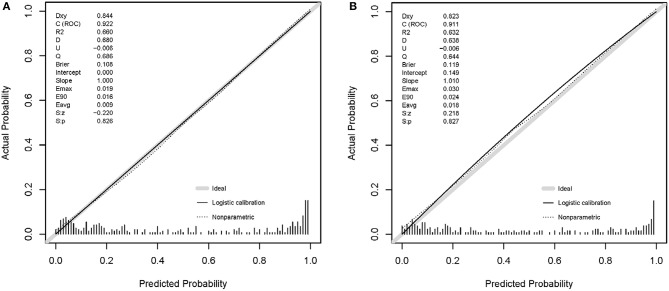
Calibration curves of the model. (A) Training set; (B) validation set.